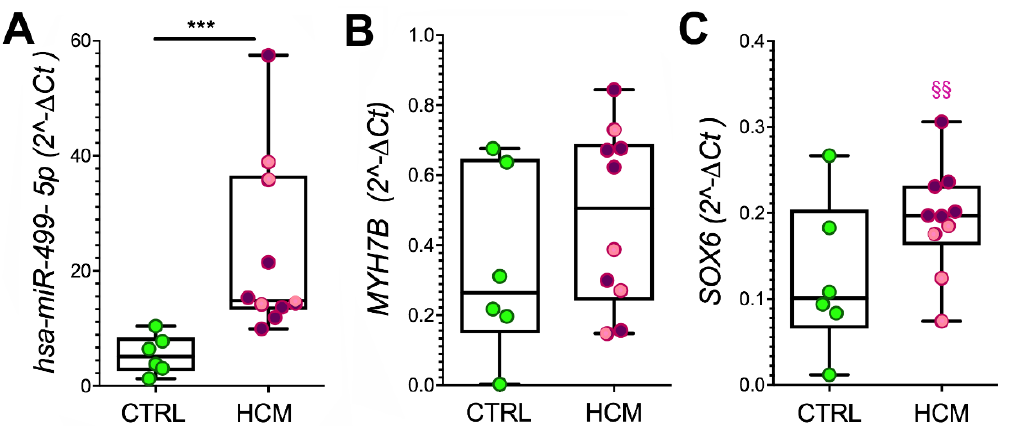
Figure 3. MYH7B, miR-499 , and SOX6 gene expression in cardiomyocytes. The levels of expressed miR-499 ( A ), MYH7B ( B ), and SOX6 ( C ) are evaluated by RT-qPCR in cardiomyocyte samples isolated from a subset of myectomies using LCM. Values are presented as boxes (min to max), and dots indicate single sample values. The distribution of miR and gene levels in HCM patients without HCM-associated mutations are presented in violet; those bearing mutations are in pink. The t -test was applied, and significant differences between HCM and CTRL are shown as *** p < 0.001. Significant difference between HCM with or without mutation is evaluated by the Mann–Whitney test, §§ p < 0.01.